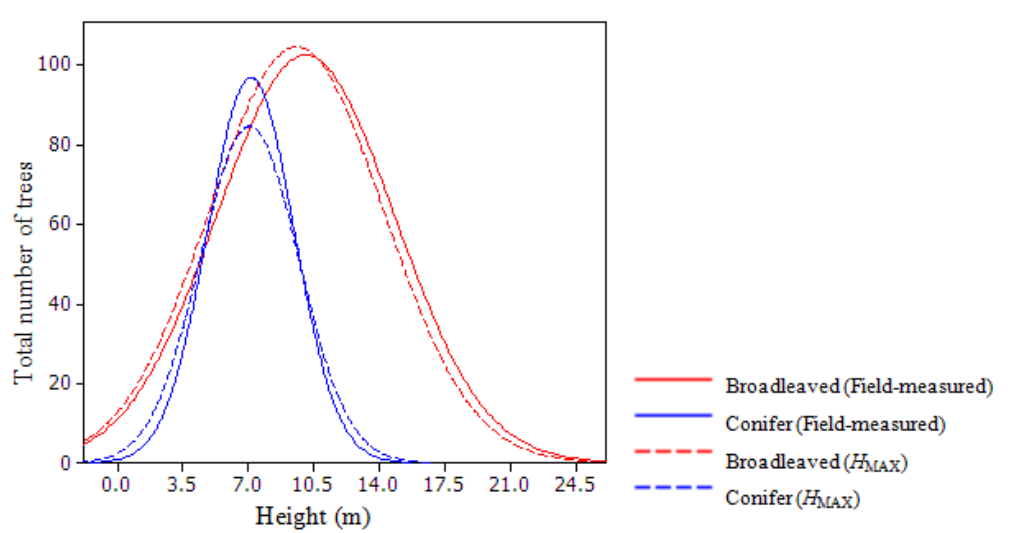
Figure 2. Distribution of trees in each class showing field measured total height (solid line) and lidar measured maximum height H (dotted line) of conifers and broad leaves. MAX